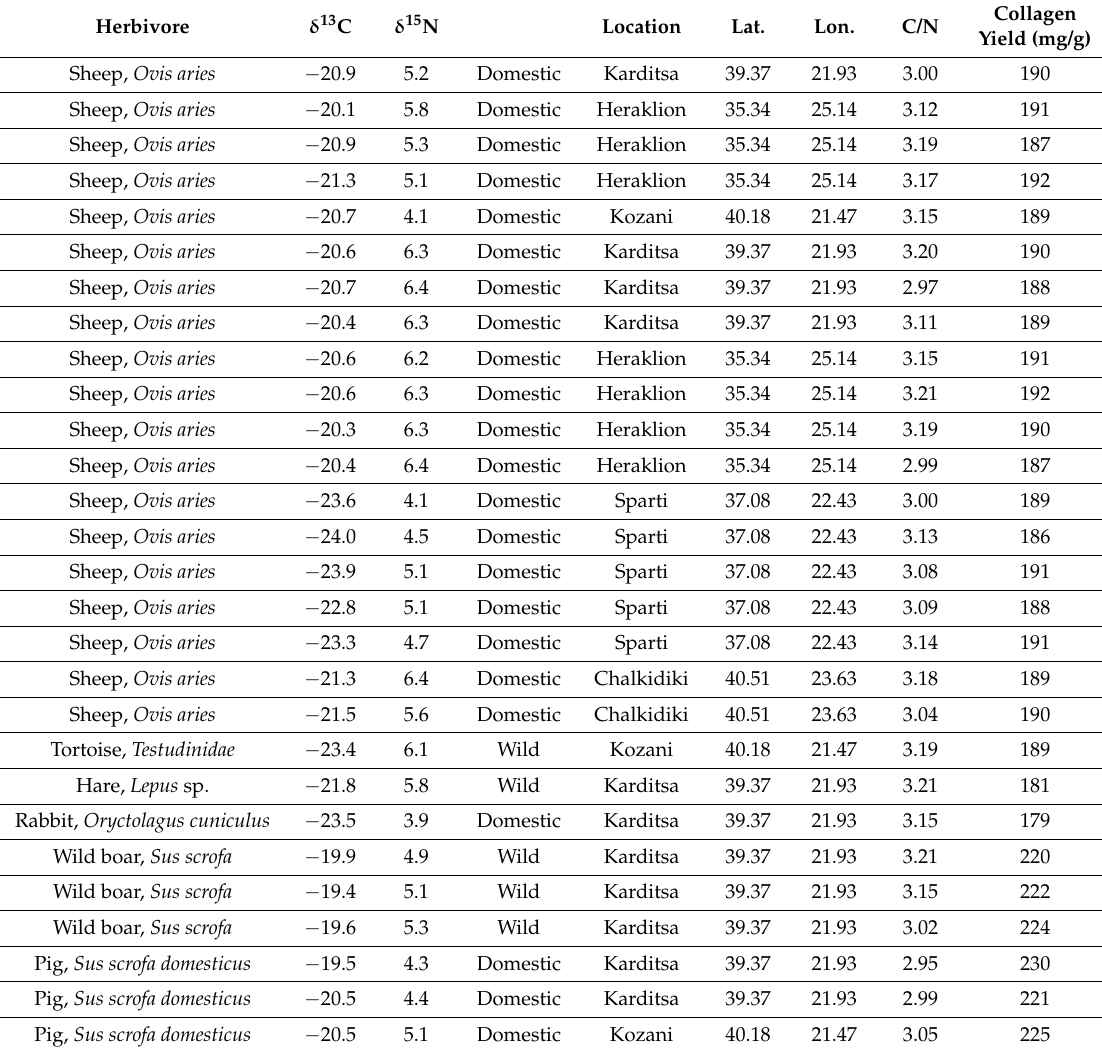
Table 3. Isotopic values of terrestrial and marine animals from